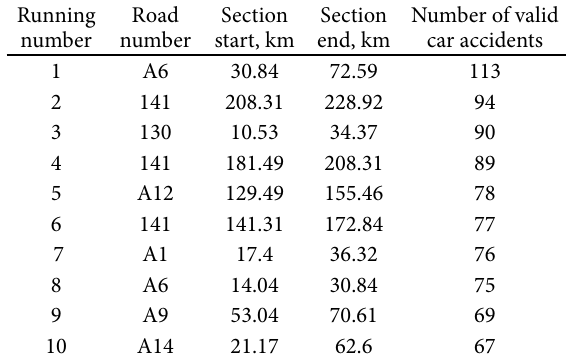
Table 3. Top 10 road sections with the highest number of valid car accidents that occurred on Lithuanian main and